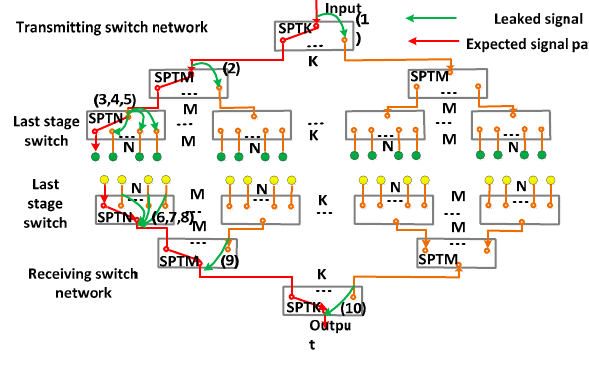
Figure 2. RF switch network. Figure 2. RF switch